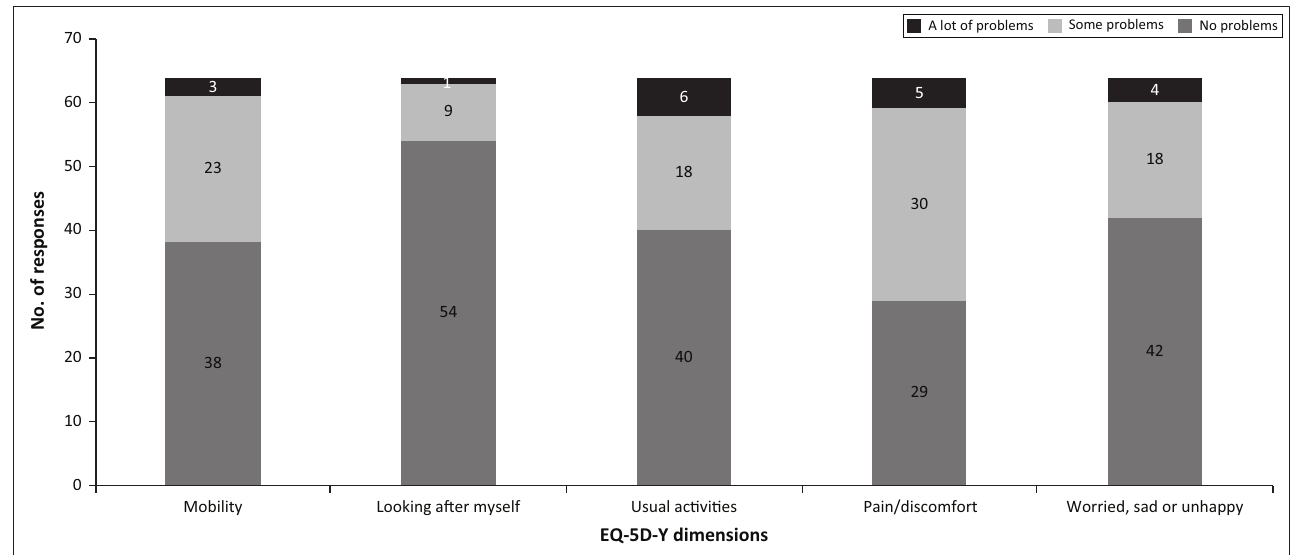
FIGURE 1: Number of problems reported in each level of EuroQol five-dimensional youth (EQ-5D-Y) questionnaire. N = 64.